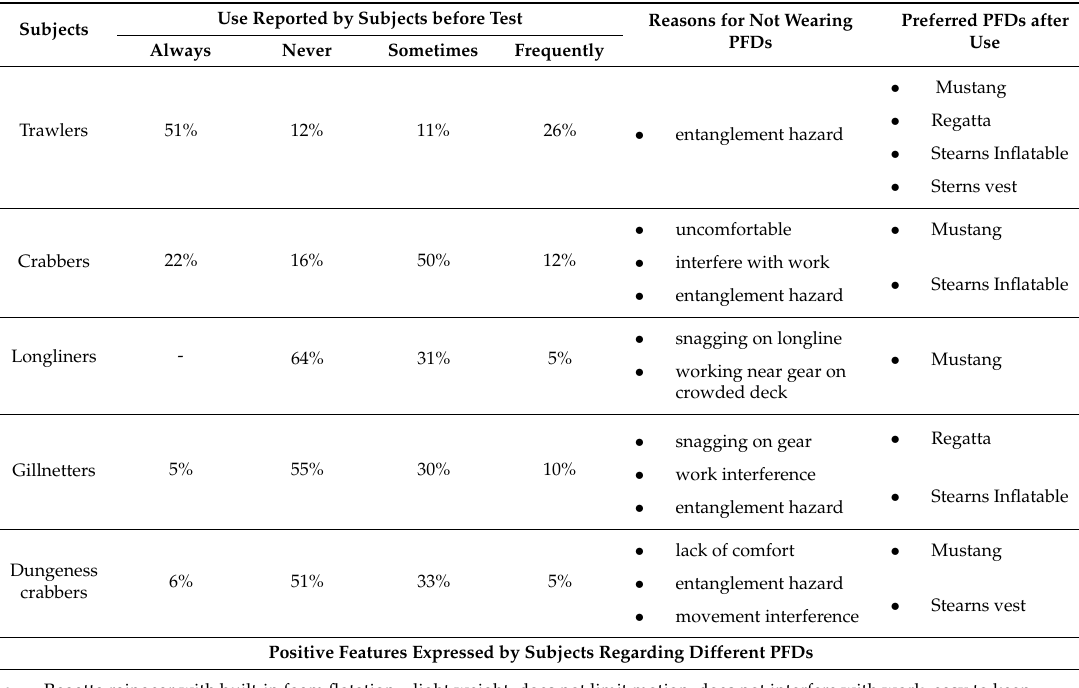
Table 4. Results of an Evaluation of Different personal flotation devices (PFDs) by Fishers (Subjects) Who Answered a Questionnaire Regarding Barriers to and/or Use of Different Types of Gear and Preferences for Alternative PFD